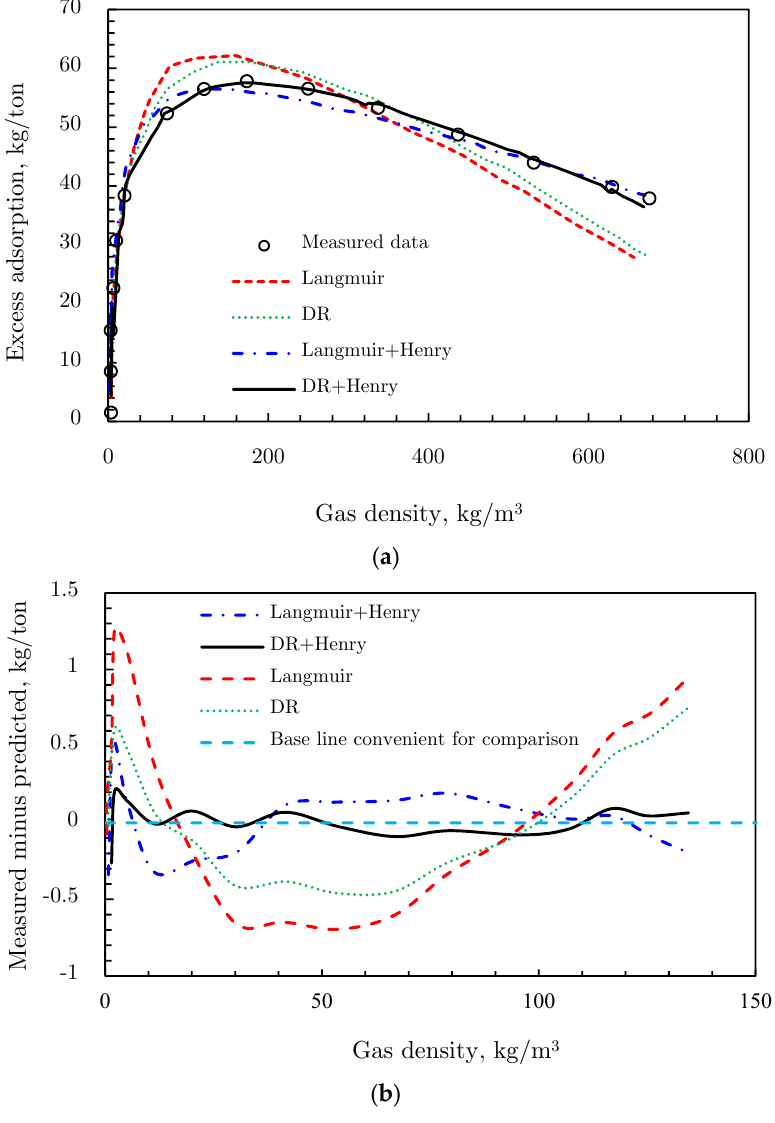
Figure 25. Fitting of models to CO 2 adsorption data ( a ) and residuals of curves from different models to CH 4 adsorption data, and the base line means the measured equals to the predicted ( b ) [81].